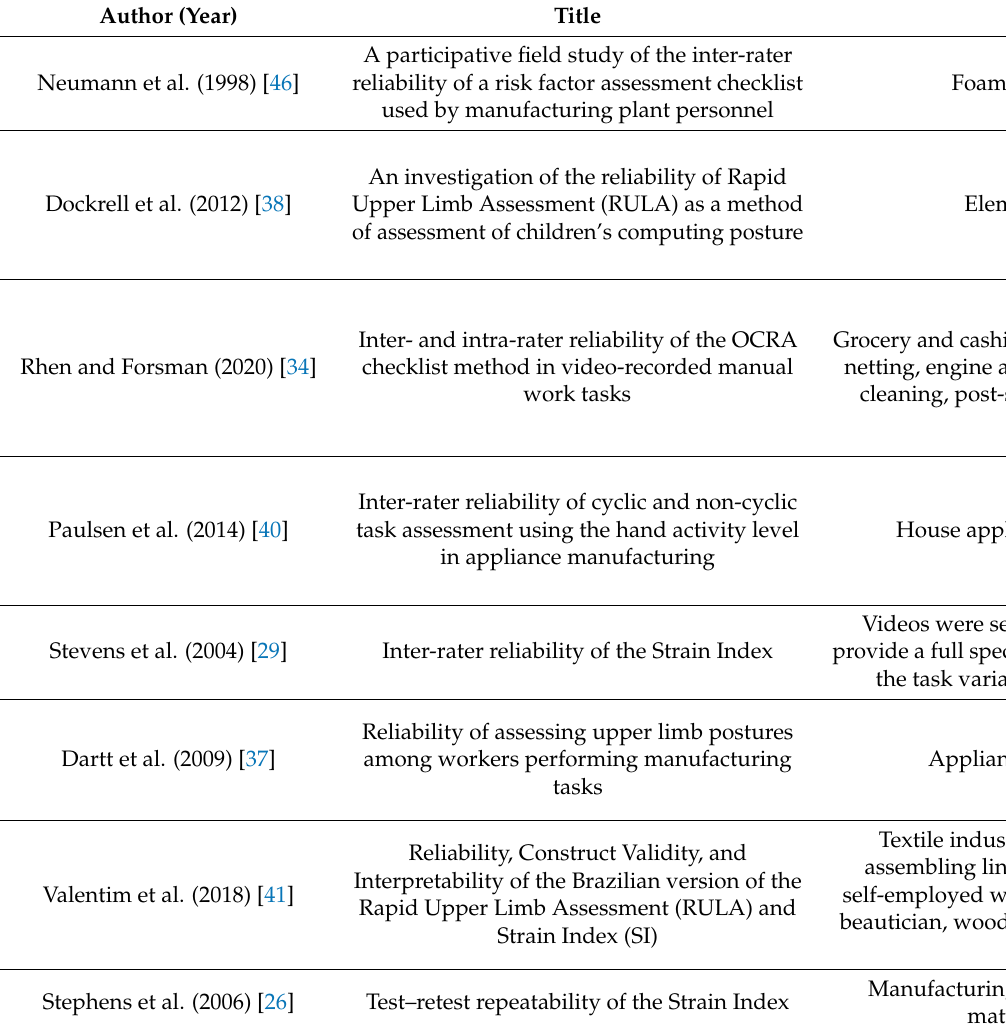
Table 1. Title, industry of interest, and stated objectives of the articles included in the review a